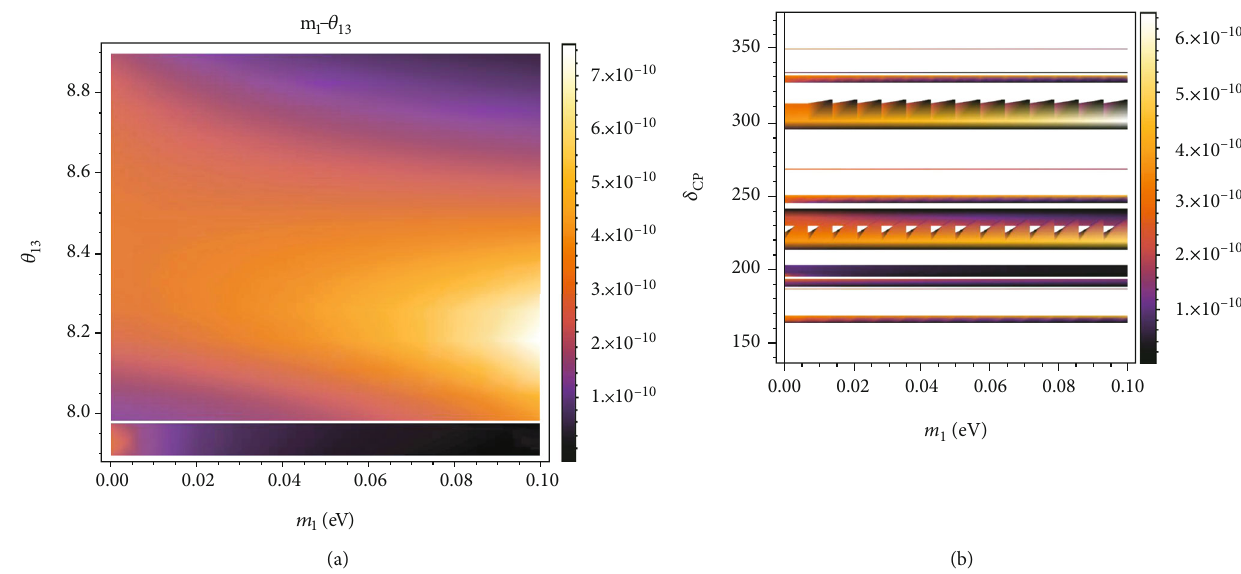
Þ plane for the , θ 1 13